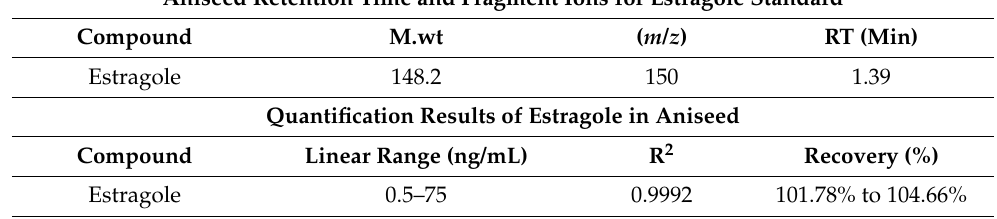
Figure 5. Calibration curve for the mean area ratio of estragole concentration (ranging from 0.50 to 75.0 ng/mL). Table 12. Fragmentation ion and the retention time for estragole standard as well as the quantitative assessment of estragole in aniseed.